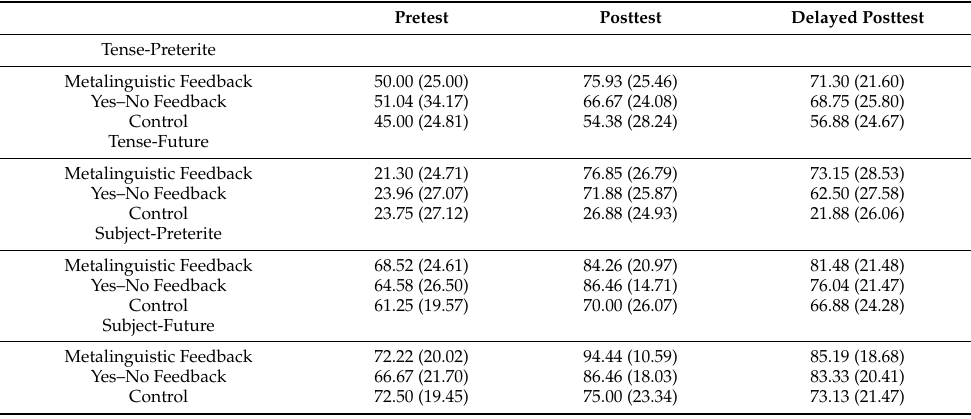
Table 4. Means (SDs in Parentheses) for Interpretation